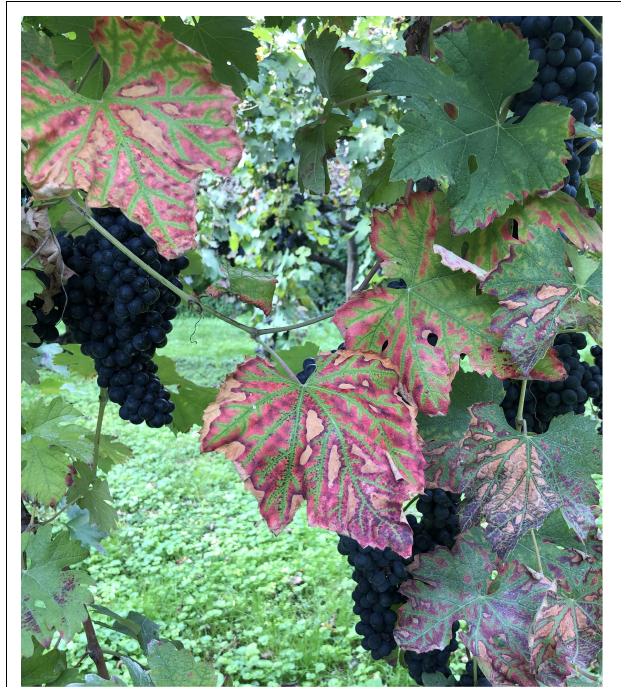
FIGURE 1 | Leaf stripe symptoms, often described as tiger stripe leaves, are the most distinctive symptom of grapevine leaf stripe disease, within the Esca complex of